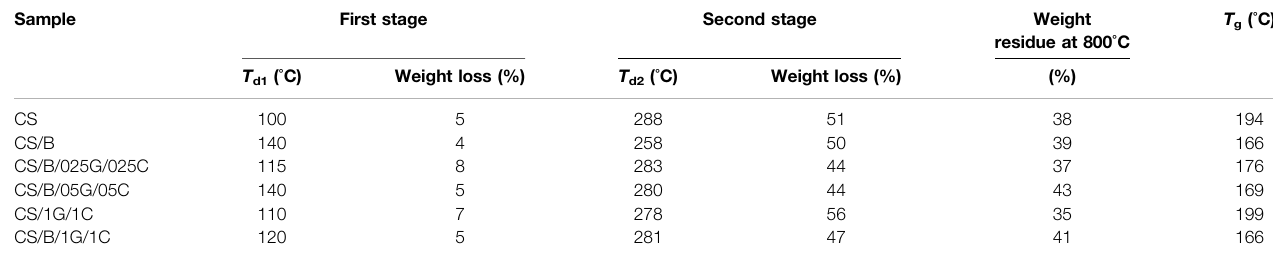
TABLE3| Maximumdecompositiontemperatures( T d )determinedfromDTAcurvesof Figure2B ,weightloss,weightresidueat800 ° C,andtheglasstransitiontemperature ( T g ) extracted from the second heating of pristine CS and composites.